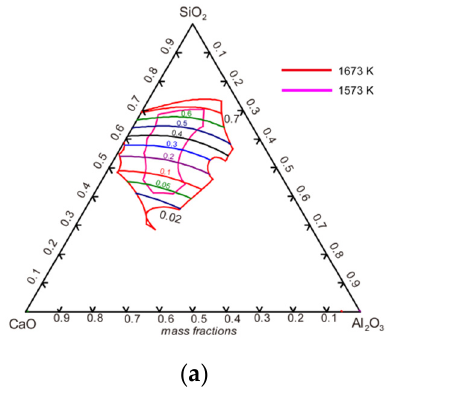
16 of 23 Figure 9. Micro and macro fracture morphologies of the steel samples. When comparing the microstructures of the four steel samples’ fractures, it was found that they all contained three kinds of microstructures, namely, secondary mi- crocracks, tear dimples and fine equiaxed dimples. With the increase in alkalinity, the microstructure at the fracture surface of the samples changed greatly: the number and size of secondary microcracks gradually increased, there were high-density large and deep holes in the fracture of the 6 # sample (these holes were likely caused by large hard inclusions), and there were not only large and deep holes but also many cleavage planes at the fracture of sample 7 # . 3.5. Thermodynamic Calculations of Isoactivity Lines The calculation of the component activity of the CaO–SiO 2 –Al 2 O 3 –MgO (10 wt.%) quaternary inclusion system was mainly completed by the phase diagram module in Fact-sage software. This part mainly calculated the isoactivity lines of CaO, SiO 2 and Al 2 O 3 when the reaction reached equilibrium at 1873 K. The results are shown in Figure 10. It was obvious that the value of decreased sharply from 0.7 to 0.02 as the value